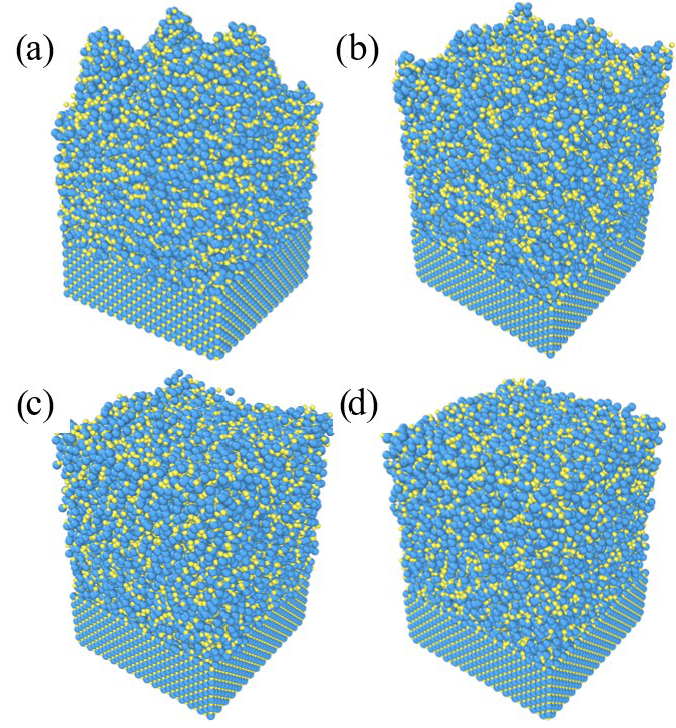
Figure 2. Atomic configurations of the TiN film at different incident energies. ( a ) 0.1 eV; ( b ) 1 eV; ( c ) 4 eV; ( d ) 10 eV. ( c ) 4 eV; ( d ) 10